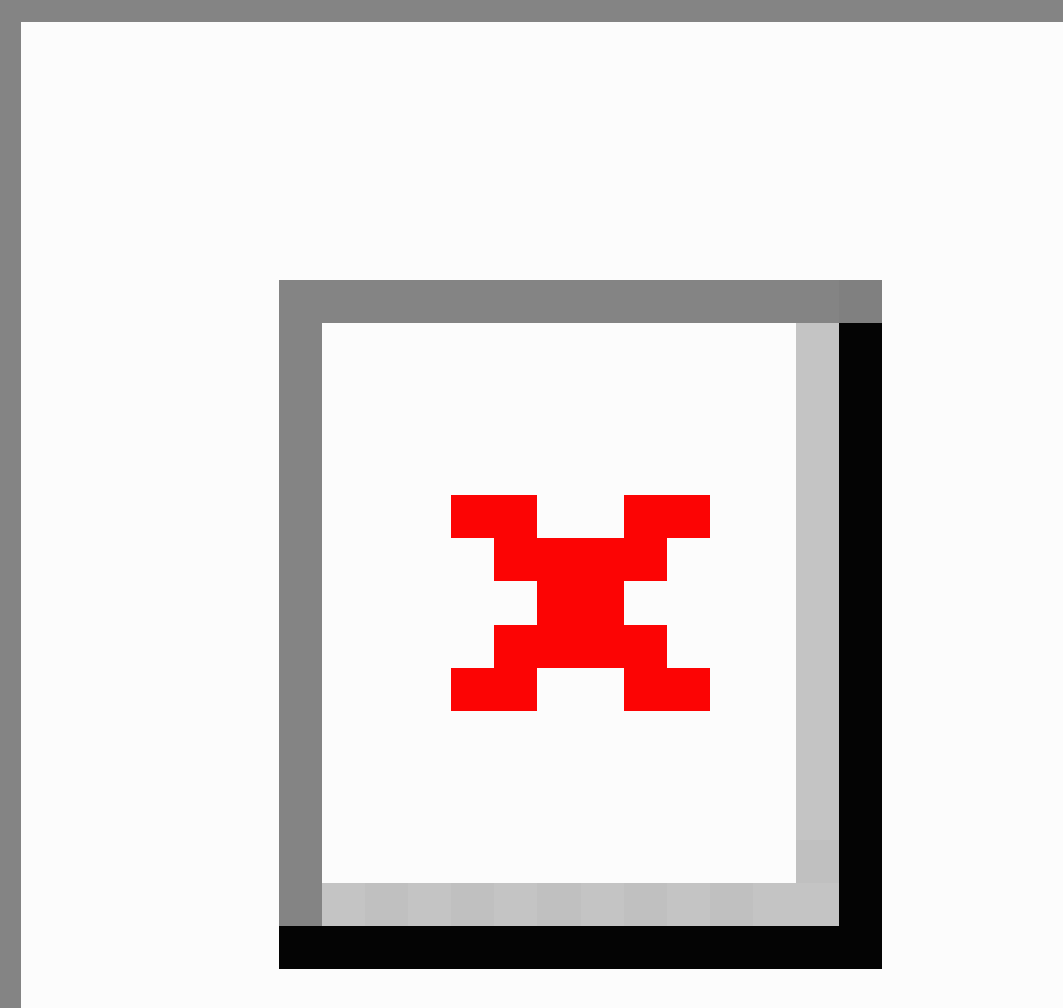
Figure 1. TB surveillance systems in Nigeria in 2015. TB: tuberculosis; TBLS: tuberculosis and leprosy